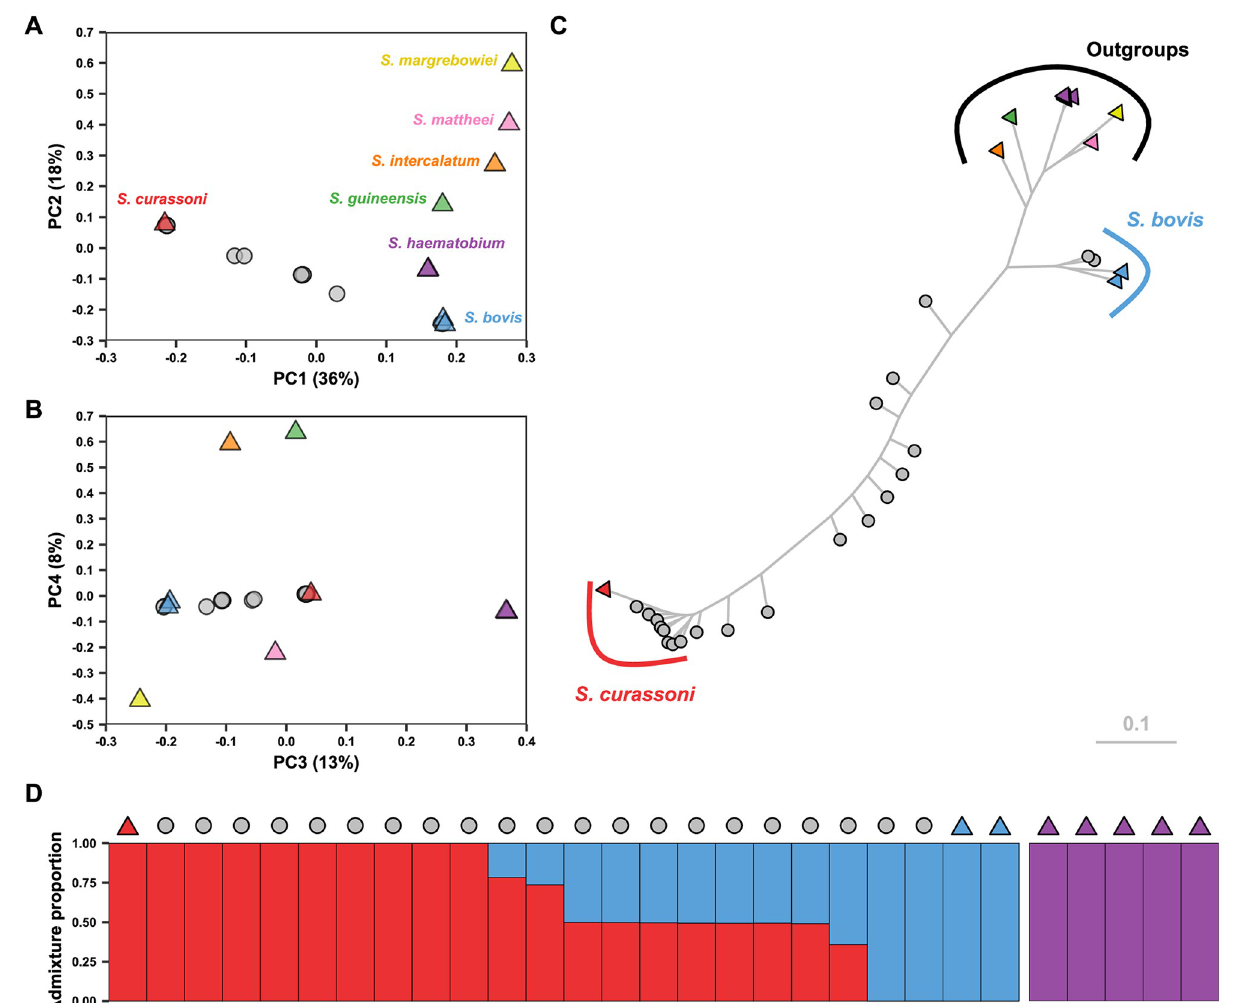
Fig 2. Population structure of sequenced isolates. Samples denoted with triangles represent reference samples, circles represent samples sequenced for this study. (A) Principal component analysis (PCA) of genomic differentiation between the 21 isolates sequenced for this study (grey circles) and the 12 samples included as references for each available Haematobium clade species (triangles): S . margrebowiei (yellow), S . mattheei (pink), S . intercalatum (orange), S . guineensis (green) S . haematobium (purple), S . curassoni (red) and S . bovis (blue). The first four principal components represented 75% of the total variance. (C) Maximum-likelihood phylogeny inferred using 23,136 parsimony informative single-nucleotide polymorphisms. Tips are coloured and shaped as in A&B, single-species and outgroups groups are highlighted. (D) ADMIXTURE plots showing the population structure, assuming three populations are present (reference samples for three species were included), we used 10-fold cross-validation and standard error estimations using 1000 bootstraps. Y-axis values show the estimated admixture proportions for each sample.